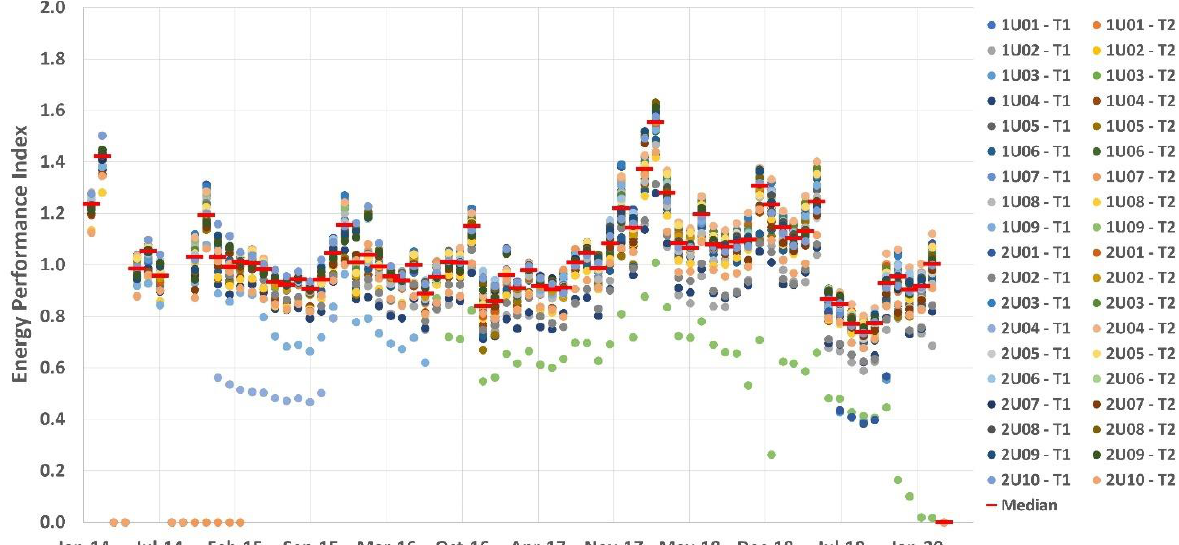
Figure 9. Energy performance index (EPI)–string (MPP trackers (MPPTs)) comparison (physical model).